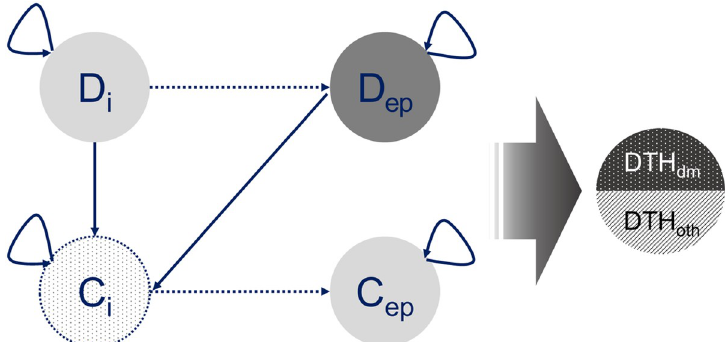
Fig 1. Markov model of type 2 diabetes including complications. Di, incident cases of type 2 diabetes; Dep, existing prevalent cases of type 2 diabetes, Ci, incident cases of complications, Cep, existing prevalent cases of complications; DTH dm, death due to diabetes; DTH oth, death due to other causes. Solid arrows: Transition probabilities directly derived from the NHIS data. Dotted arrows: Hypothetical transitions explaining the conversion of transition probabilities from incidence to existing prevalence after five